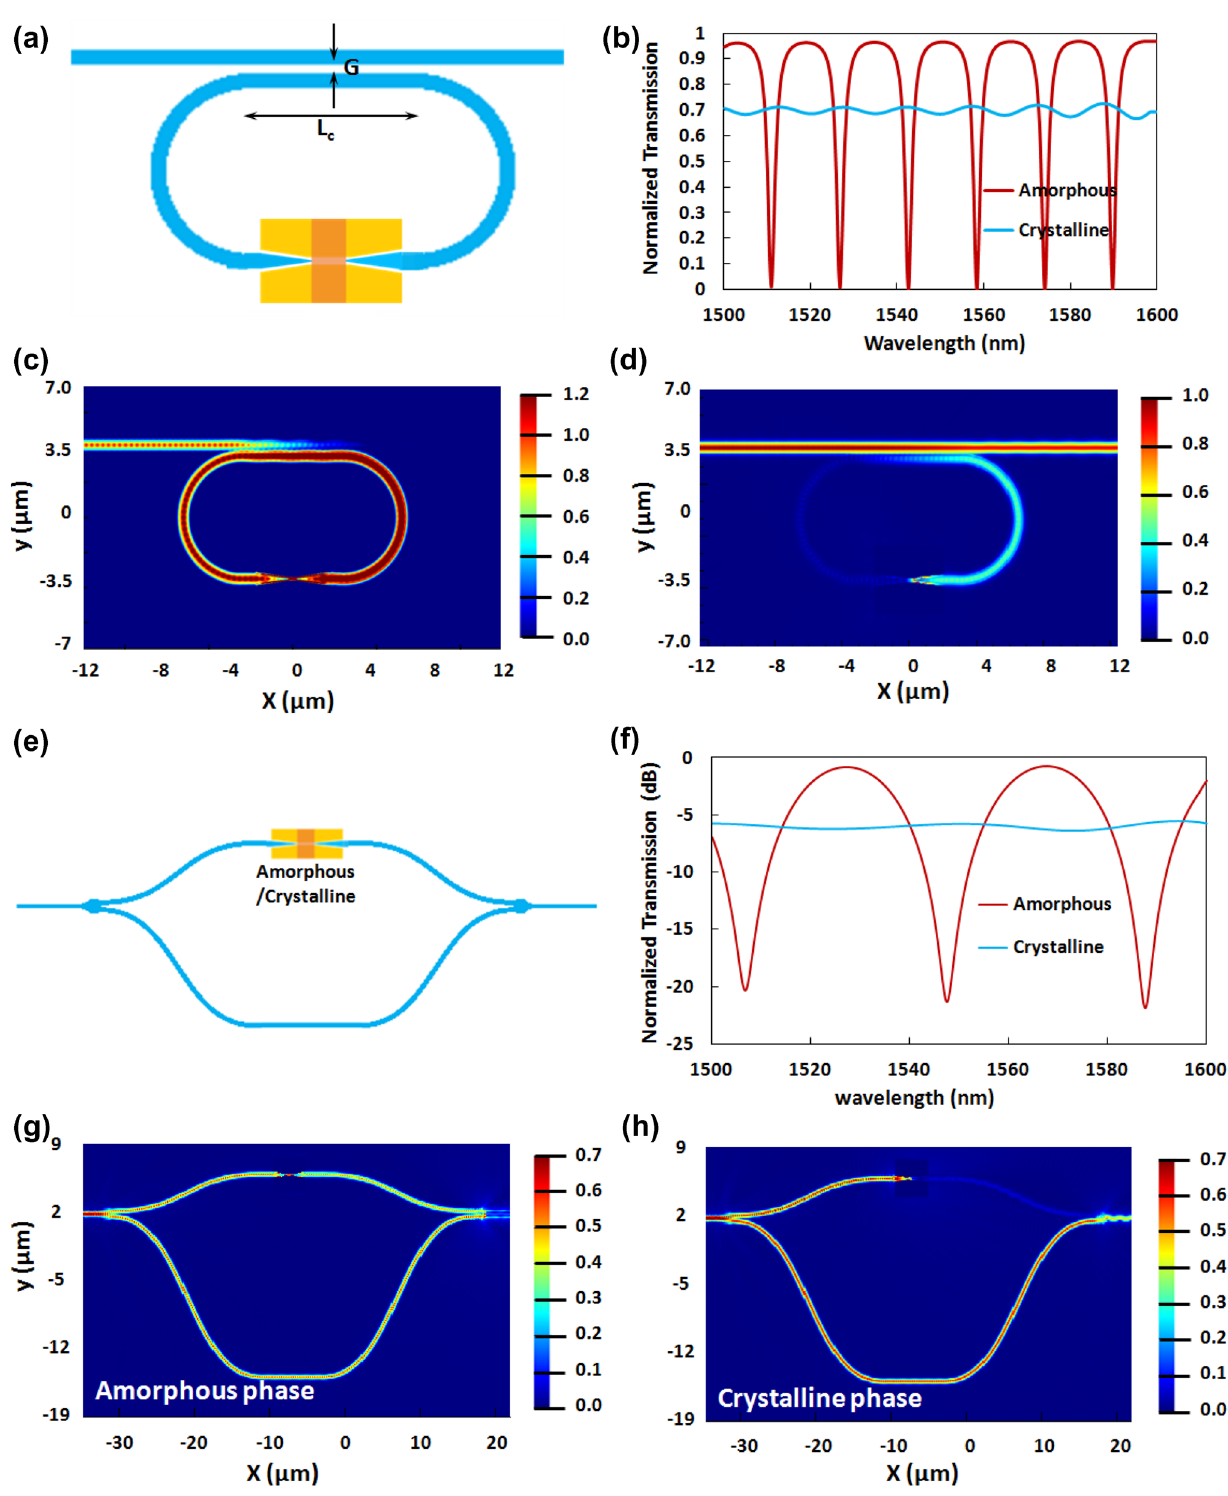
Figure 3. ( a ) Schematic of the racetrack microring resonator based electro-optic switch having the hybrid non-volatile electro-optic plasmonic switch as the fundamental unit. ( b ) The normalized transmission spectra of the racetrack microring resonator based electro-optic switch for the amorphous phase and the crystalline phase of the PCM (GST) layer. ( c )–( d ) The optical electric field distribution of the proposed electro-optic switch at the resonance wavelength of 1558 nm for ( c ) the amorphous phase and ( d ) the crystalline phase of the PCM layer. ( e ) Schematic of the asymmetric MZI based electro-optic switch having the hybrid non-volatile electro-optic plasmonic switch as the active element in one arm. ( f ) The normalized transmission spectra of the asymmetric MZI based electro-optic switch for the crystalline phase and the amorphous phase of the PCM (GST) layer in the plasmonic switch. ( g ),( h ) The optical electric field distribution of the proposed electro-optic switch at the resonance wavelength of 1548 nm for the ( g ) amorphous phase and ( h ) the crystalline phase of the PCM